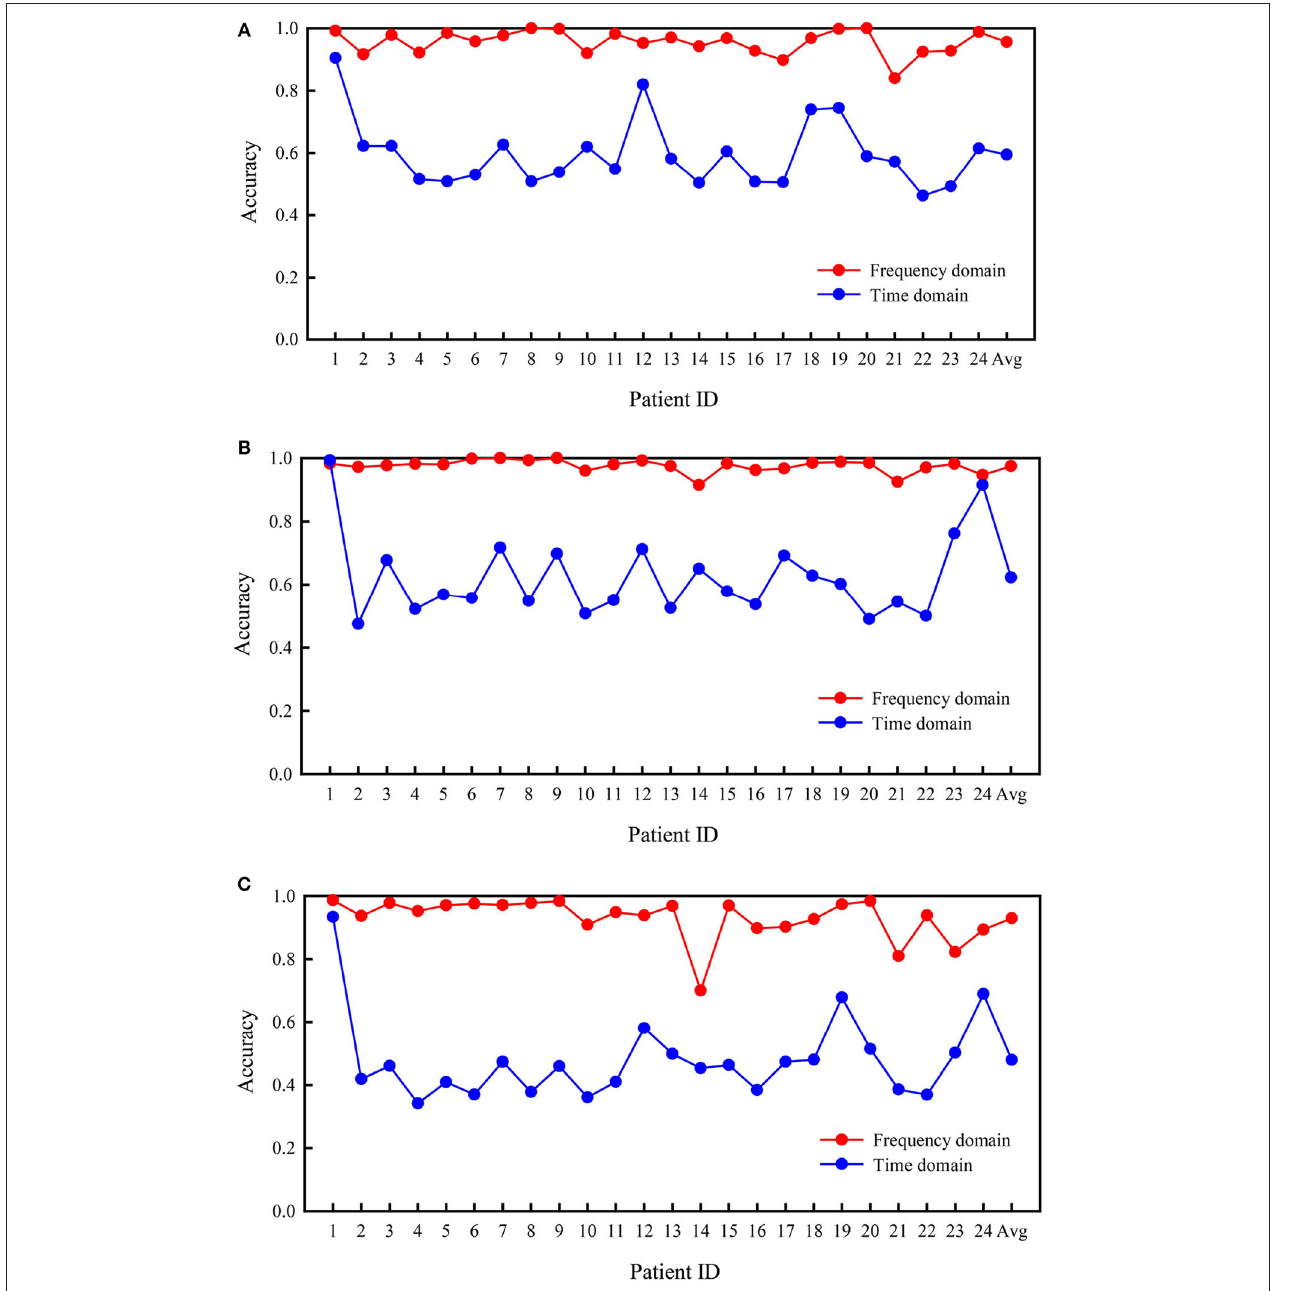
FIGURE 5 | Comparison of accuracies based on frequency and time domain signals from subjects in the CHB-MIT database. (A) Interictal vs. preictal. (B) Interictal vs. ictal. (C) Interictal vs. ictal vs.